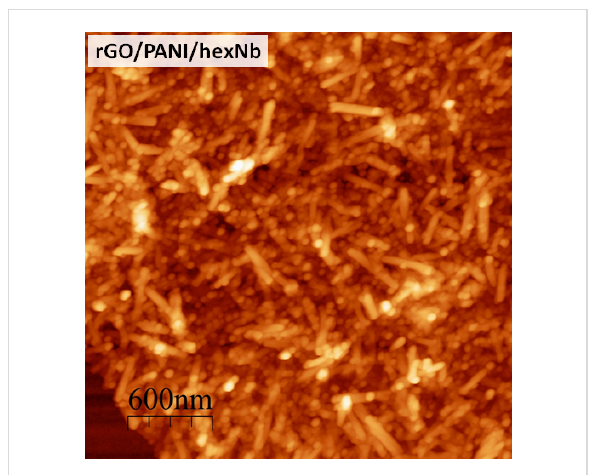
Figure 3: AFM images of rGO/PANI/hexNb nanocomposite at 3 μ m scan